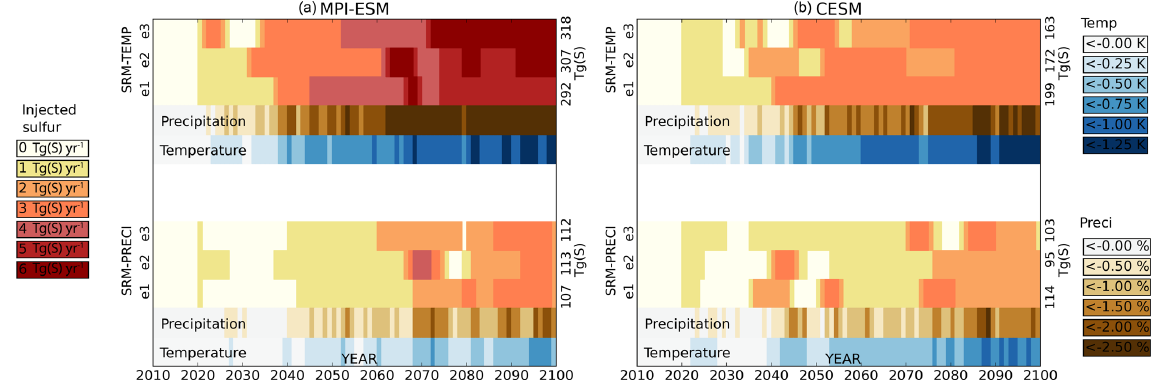
Figure 8. Yearly sulfur injections in scenarios SRM-TEMP and SRM-PRECI for three ensemble members in MPI-ESM (a) and CESM (b) . Also shown are the corresponding global mean precipitation and temperature differences relative to RCP4.5. The cumulative injection amount for each ensemble member is listed on the right-hand